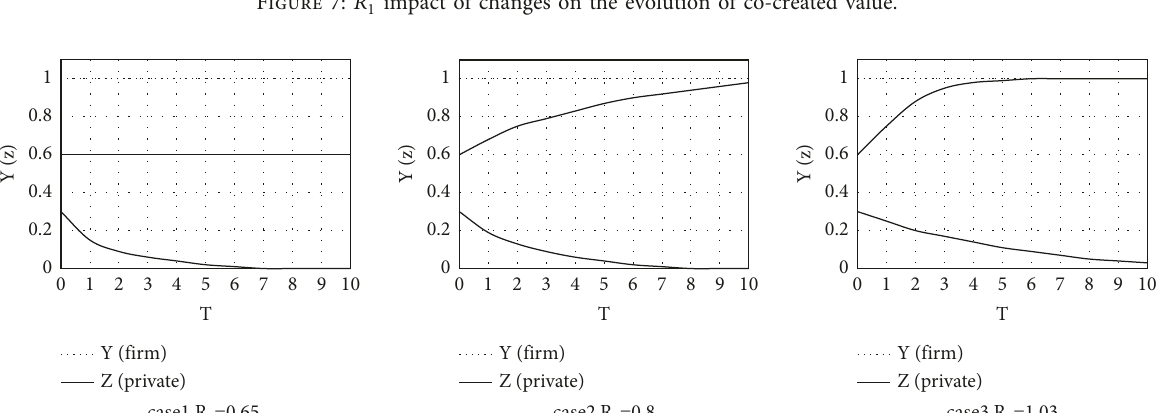
Figure 7: R 1 impact of changes on the evolution of co-created value.